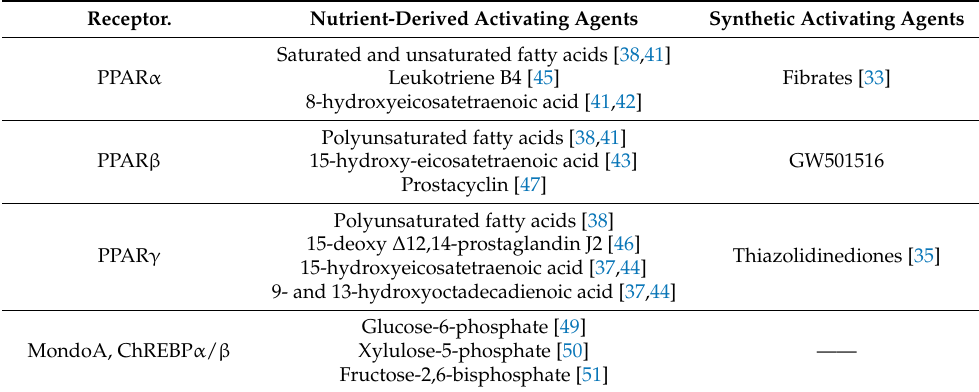
Table 1. Nutrient-derived and synthetic activating agents of PPARs and ChREBP.